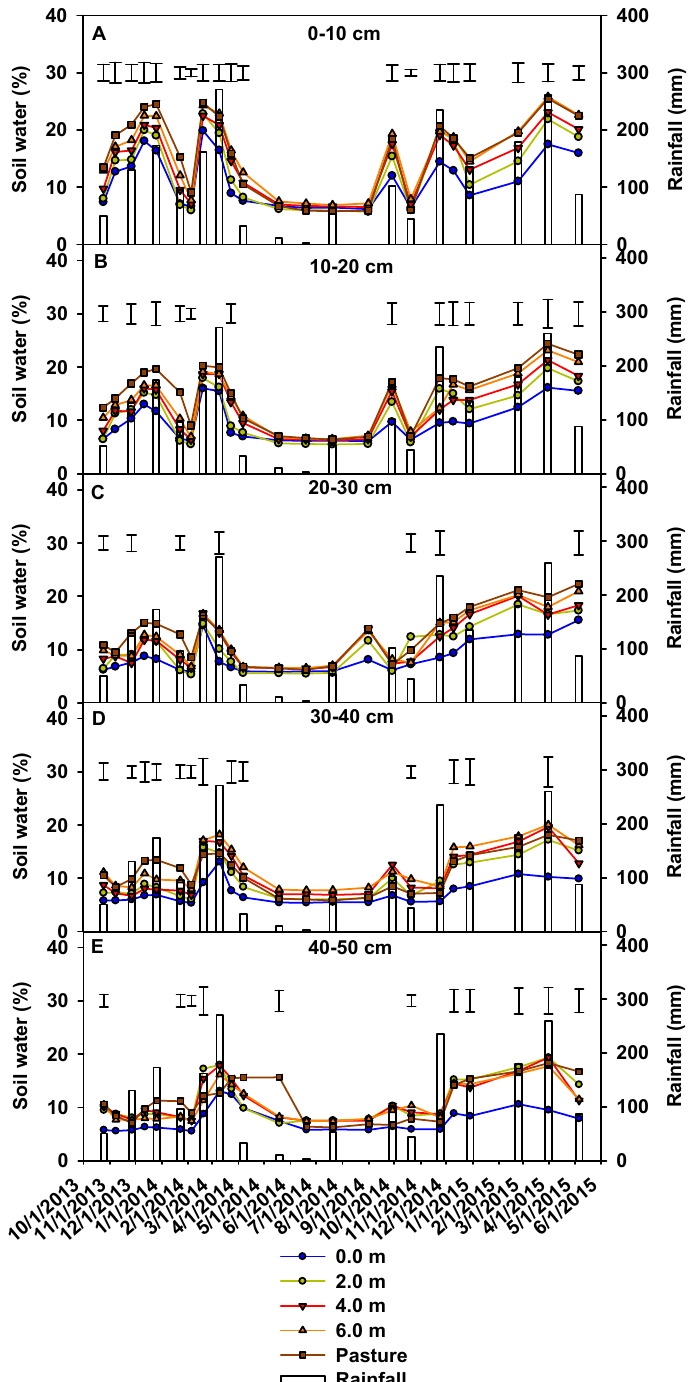
Figure 2. Average soil water content at soil depths of ( A ) 0–10 cm, ( B ) 10–20 cm, ( C ) 20–30 cm, ( D ) 30–40, and ( E ) 40–50 cm as a function of sampling location: 0.0 (planting row), 2.0, 4.0, and 6.0 m from the Eucalyptus tree rows and in monoculture pasture. Bars indicate LSD (0.05) values for dates with significant differences between sampling locations.